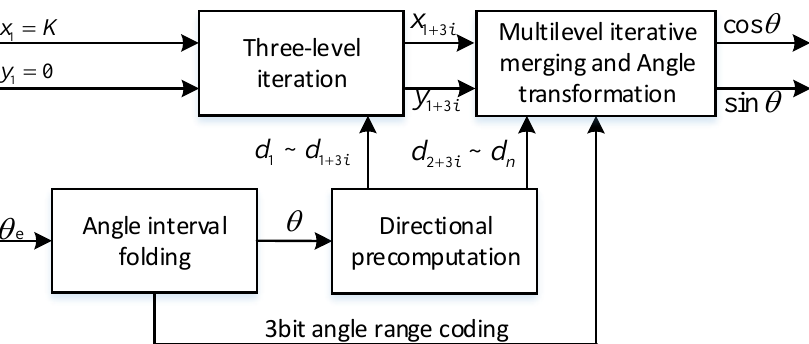
Figure 5. Implementation of RDP-CORDIC algorithm with sine and cosine functions.